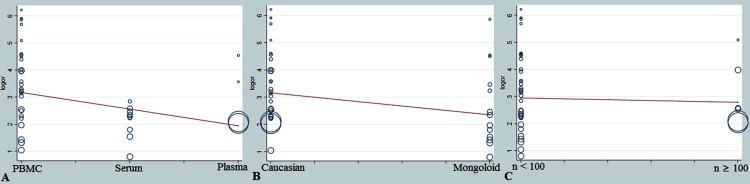
The meta-regression of the enrolled studies.(A) For the type of samples, the meta-regression detected it was a dramatic impact on the homogeneity of the enrolled studies, P = .030, t = -2.17, 95%CI (0.30, 0.96). (B) For the ethnicity of studies, the meta-regression did not find it was a dramatic impact on the homogeneity of the enrolled studies, P = .056, t = -1.97, 95%CI (0.20, 1.02). (C) For the SLE sample sizes, the meta-regression did not detect it was a dramatic impact on the homogeneity of the enrolled studies, P = .77, t = -0.30, 95%CI (0.29, 2.52). The meta-regression could determine the correlation between the potential factors and the existing heterogeneities. When a significant difference was discovered, the factor should have a dramatic impact on the homogeneity of the enrolled studies with a P value <0.05. or, odds ratio. CI, confidence interval.